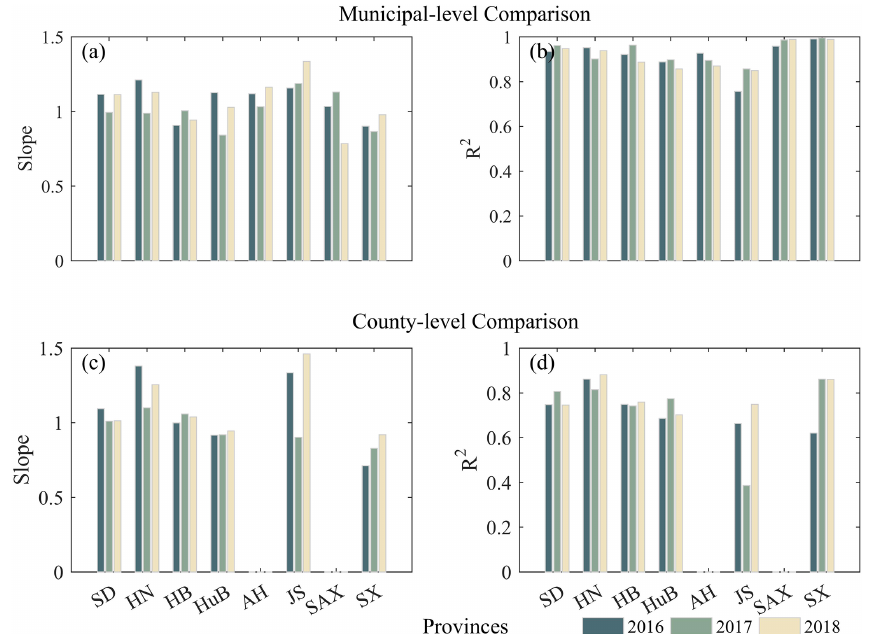
Figure 10. Comparison between the estimated and statistical winter wheat area at the municipal (a, b) and county level (c, d) for the period of 2016–2018. The agricultural statistical area at the county level for AH and SAX are not